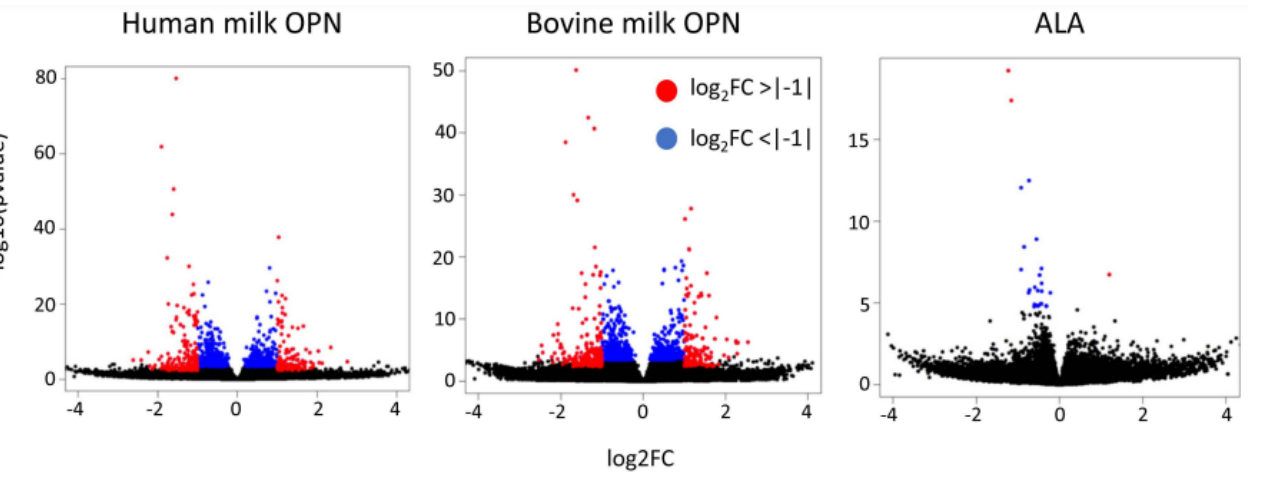
Figure 1. Volcano plots of the human milk OPN, bovine milk OPN, and a whey protein fraction with a high content of alpha-lactalbumin (ALA) treatments. Red (log 2 FoldChange >| − 1|) and blue (log 2 FoldChange <| − 1|) dots show the significant genes.